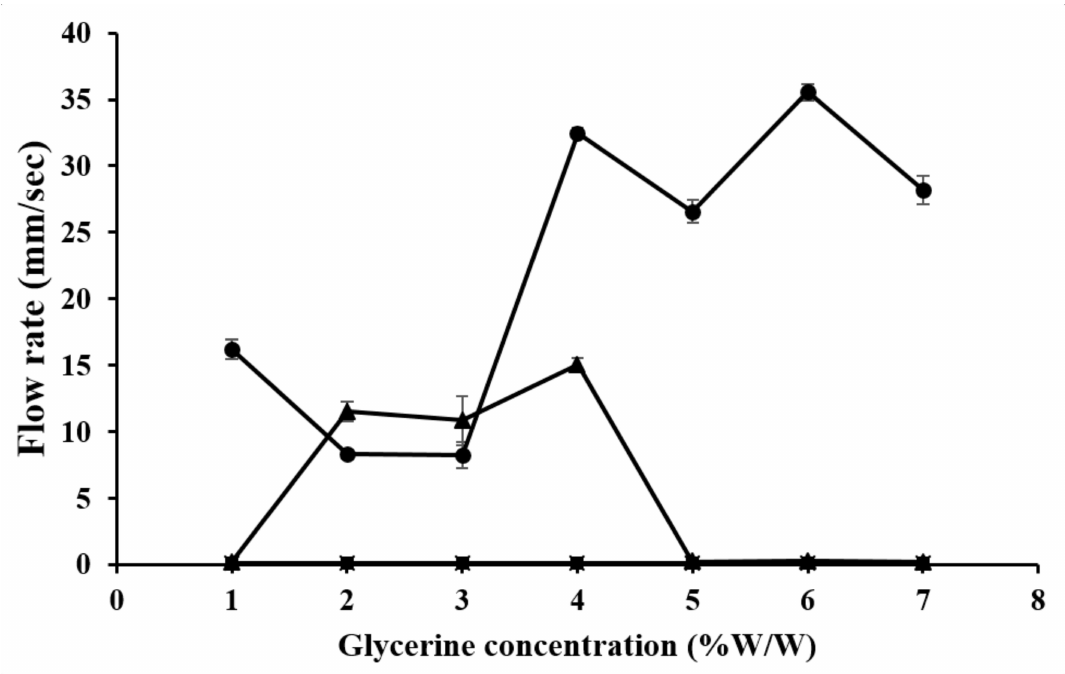
Figure 7. Flow rate on a tilted aluminum plate of gels prepared from ( (cid:4) ) 4% carboxymethyl cellulose (CMC), ( • ) 5% low molec- ular weight chitosan (LMCS), and ( (cid:78) ) 6.25% high molecular weight chitosan (HMCS) with different glycerin